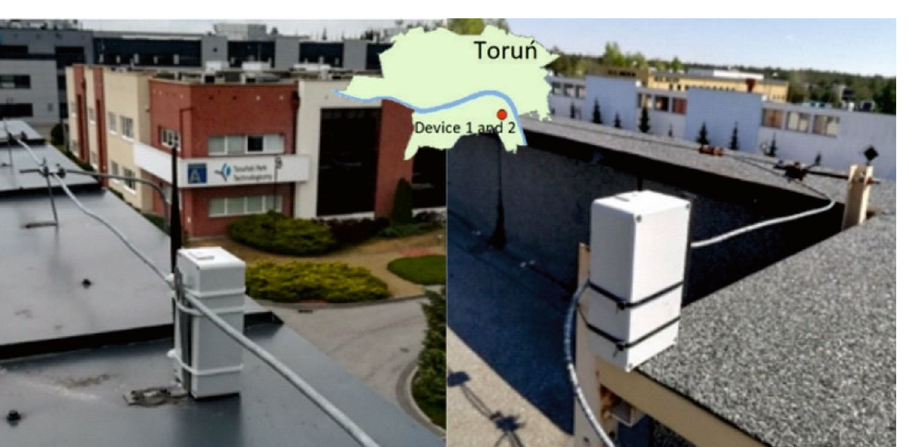
Figure 5. Automatic device (1 and 2) measuring the brightness of the sky, placed on one of the buildings in TARR (photo by Mieczysław